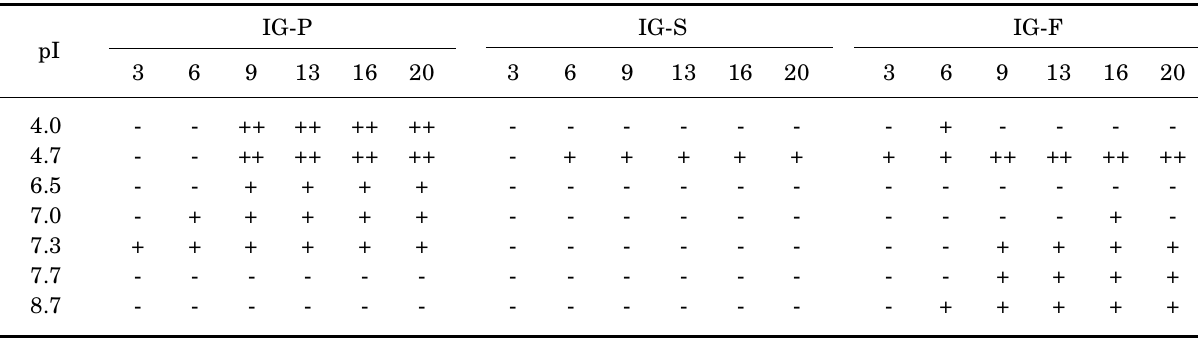
Table 2. Extracellular polygalacturonase isozymes produced by the intersterile groups (IGs) P, S and F of Heteroba- sidion annosum at various days from inoculation in a liquid growth medium containing pectin as the sole carbon source.